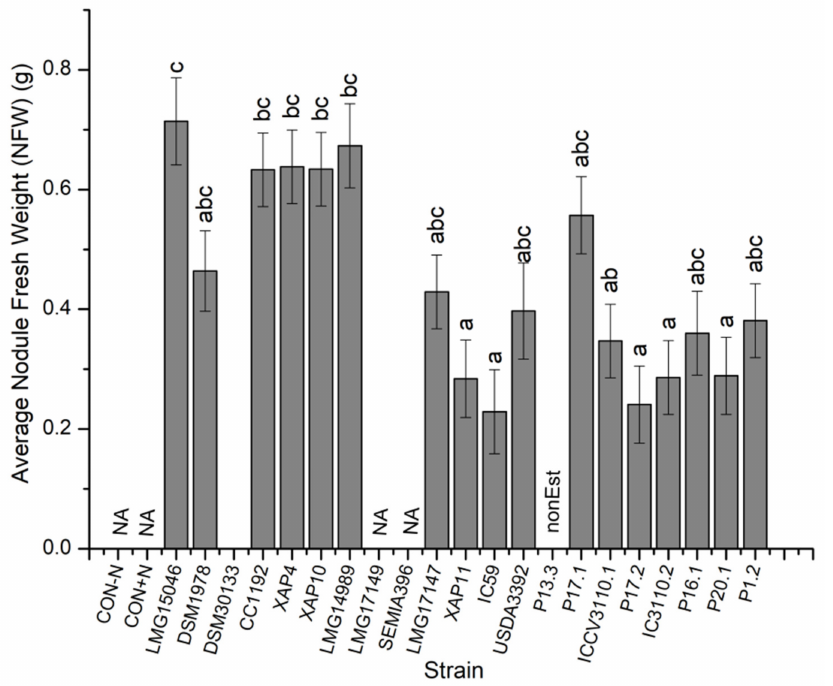
Figure 3. The graph of the effects of the Mesorhizobium isolate on nodule fresh weight (NFW) of chickpea. Bars are means ± standard errors, n = 3. Different letters (a–c) above the bars indicate treatments with significant differences ( p < 0.05). NA = no nodules formed, nonEst = not estimated. For NFW, plants inoculated with strain LMG15046 significantly outperformed those inoculated with strains XAP11, IC59, ICCV3110.1, P17.2, IC3110.2, and P20.1 (Figure